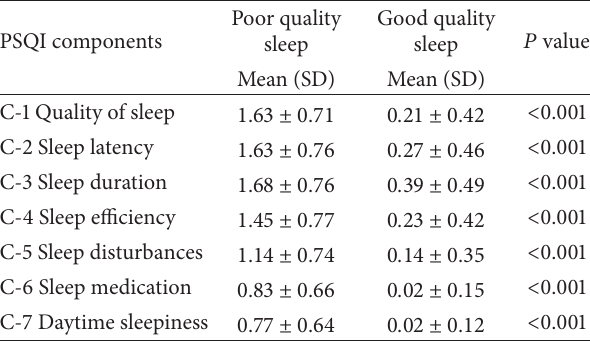
Table4:ComparisonoftheindividualcomponentscoreofthePSQI amongst patients with poor and good quality